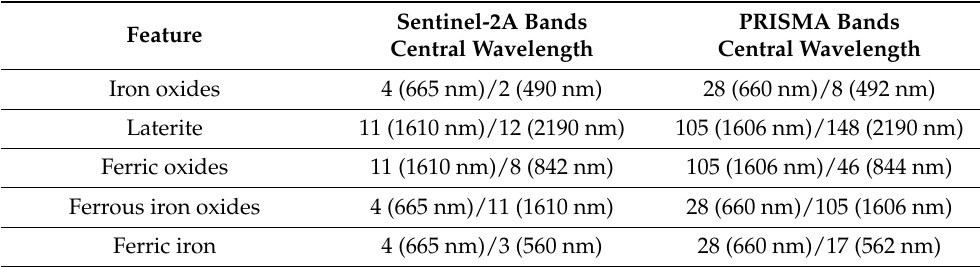
Table 1. Band ratios of Sentinel-2A used as proxies for mapping different mineralogy.